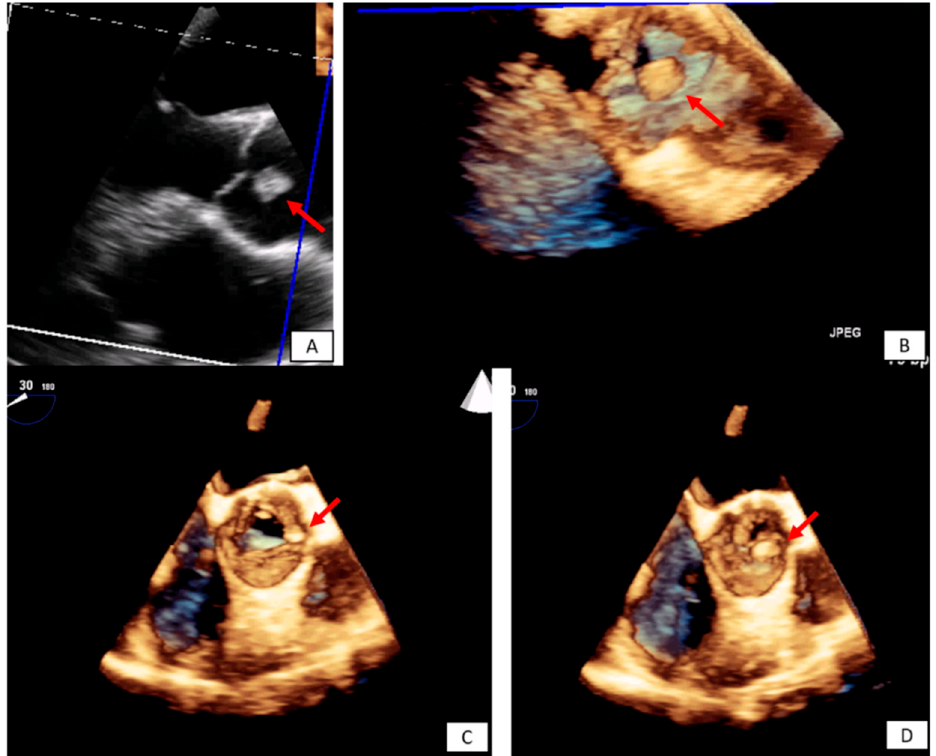
Figure 5. Incidental finding on TTE in an asymptomatic patient followed by TEE. The transesophageal image revealed a papillary fibroelastoma attached to the left cusp of the aortic valve (red arrows) 3D TEE with cropping in long axis ( A , B ), and short axis view (( C , D ) during systole and diastole, respectively). Please note that the pedunculated lesion is attached on the tip of the aortic surface of the aortic valve, is not protruding in the LVOT during systole and doesn’t lead to valve destruction or insufficiency.